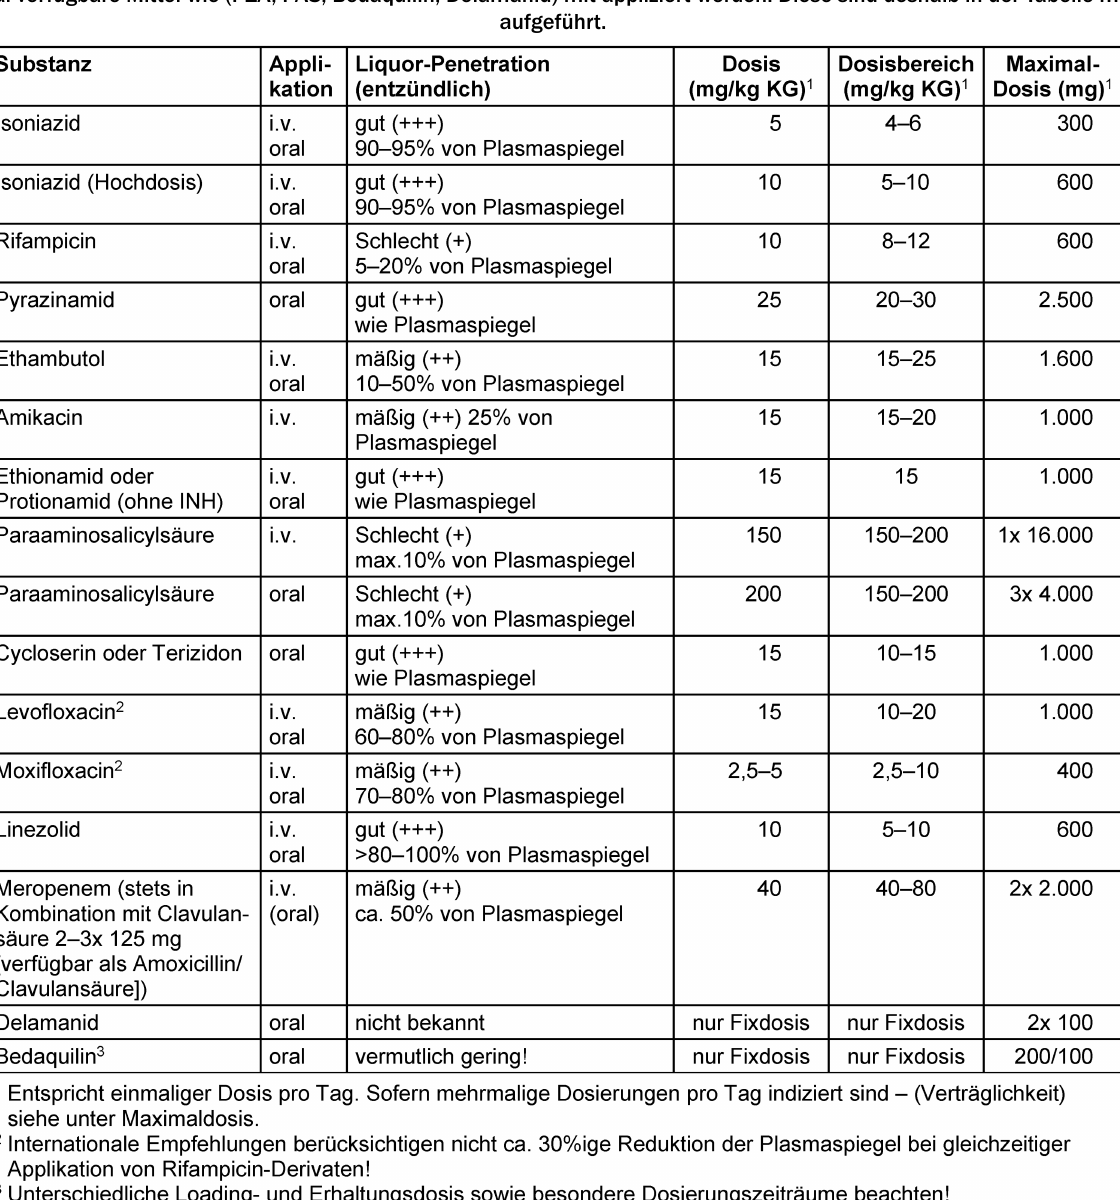
Tabelle 4: Tuberkulose-Meningitis: Dosierungsempfehlungen nach nationalen und internationalen Leitlinien. Da bei